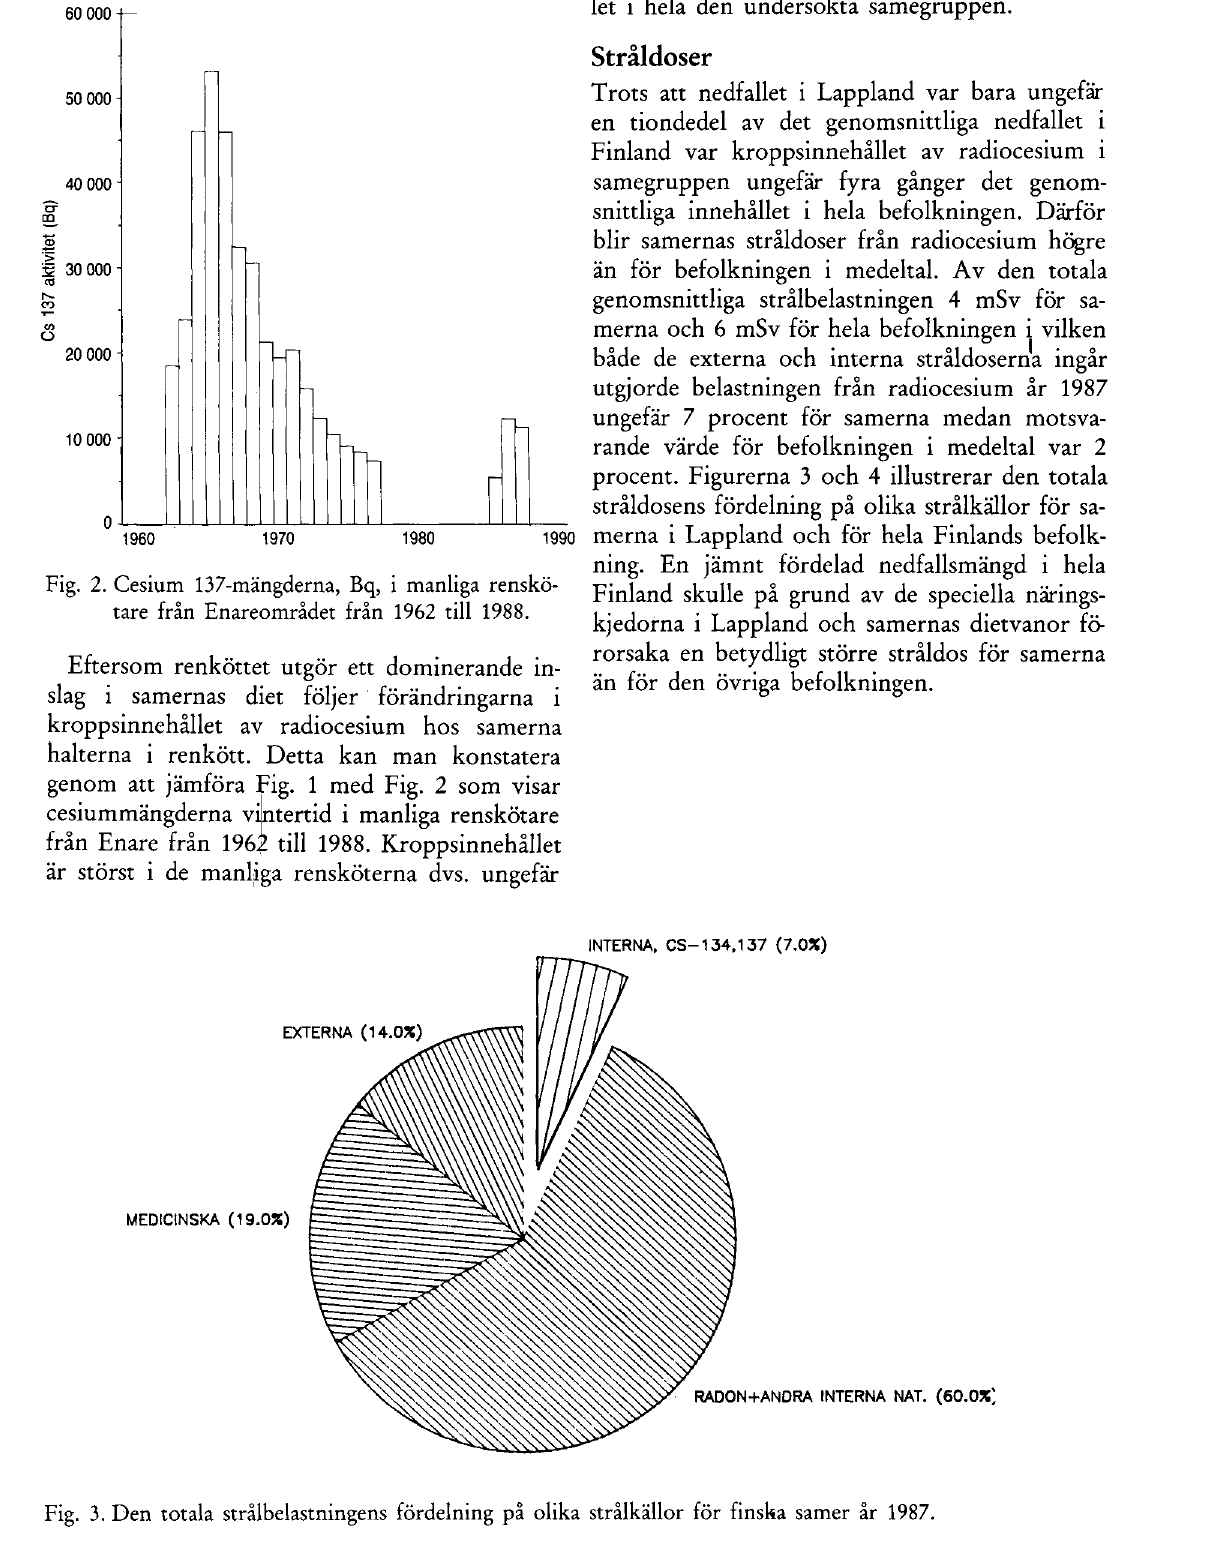
Fig. 3. Den totala strålbelastningens fordelning på olika strålkallor for finska samer år 1987. Rangif er, Special Issue No.